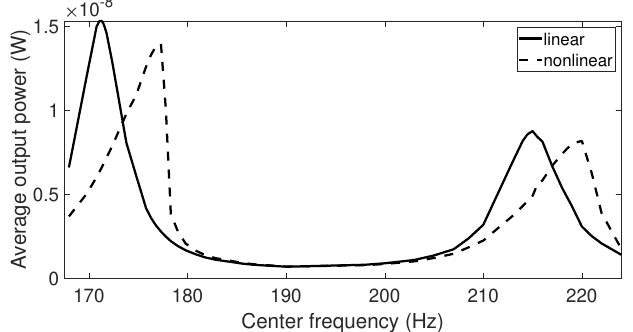
Figure 13. The average output power response for the linear and nonlinear prototypes under air-pump excitation when the center frequency of the excitation is swept.